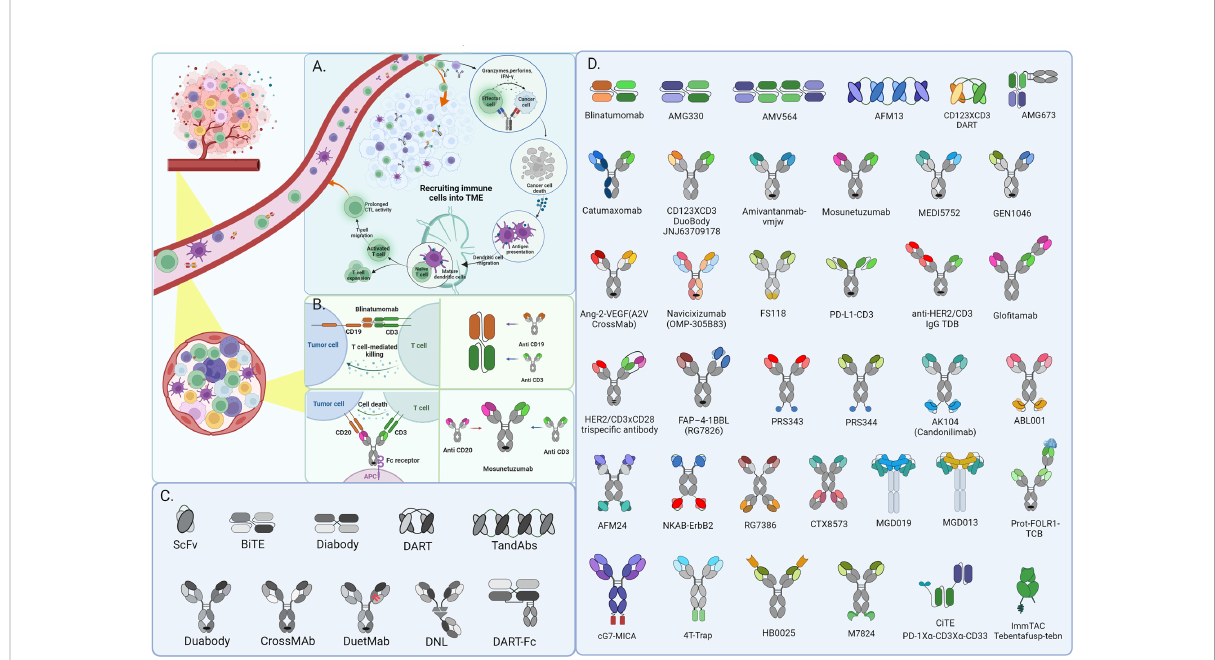
FIGURE 1 CD3+ bispeci fi c T-cell engaging antibodies exert function in Hematological Malignancies and recruit immune cells into the solid tumor microenvironment for cancer immunotherapy. The schematic depicts the mechanism of action of BsAbs in solid tumors (A) and Hematological Malignancies (B) . besides, there shows partial fragments of antibody as well as the derivatives formats constructed from them in diagram (C) and various architecture of BsAbs in diagram (D) mentioned in this